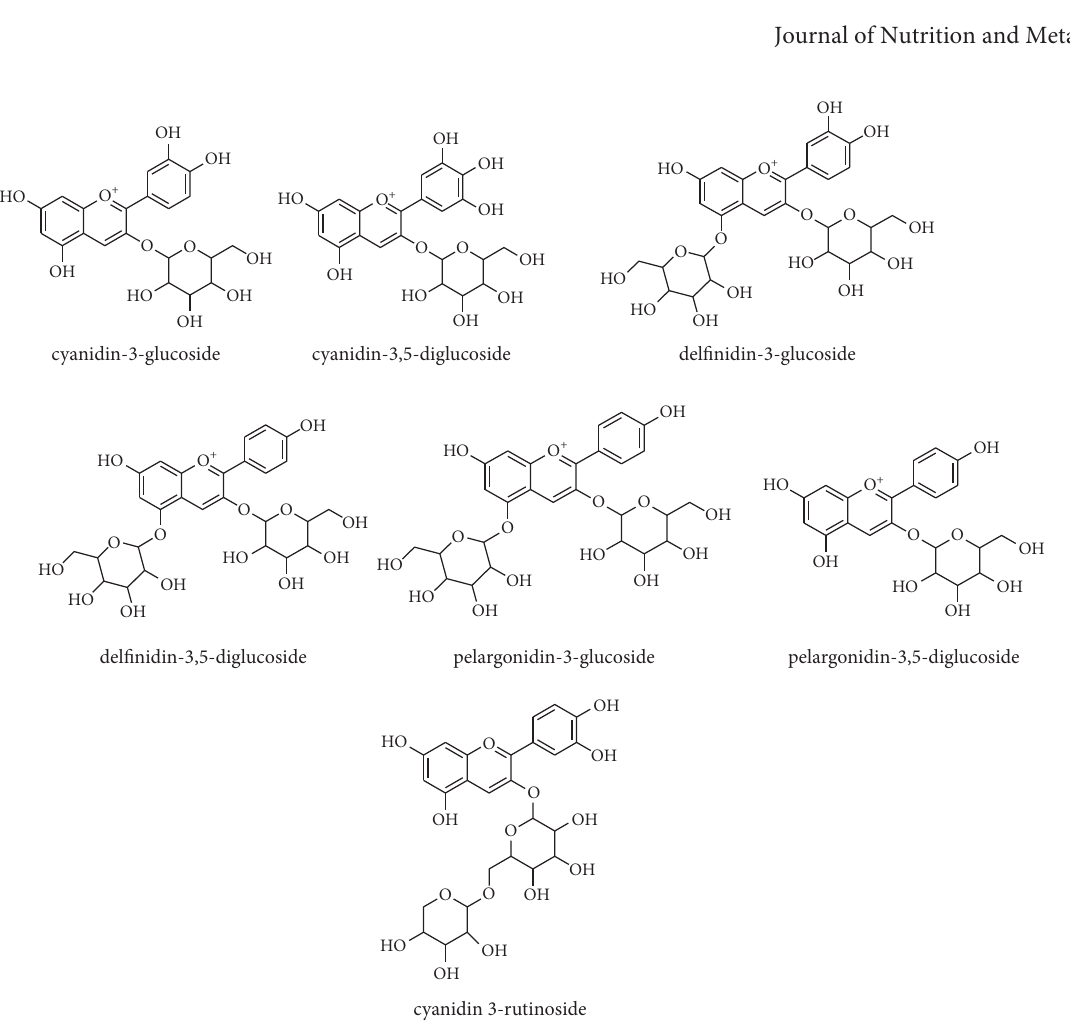
Figure 2: The main anthocyanoside compounds in